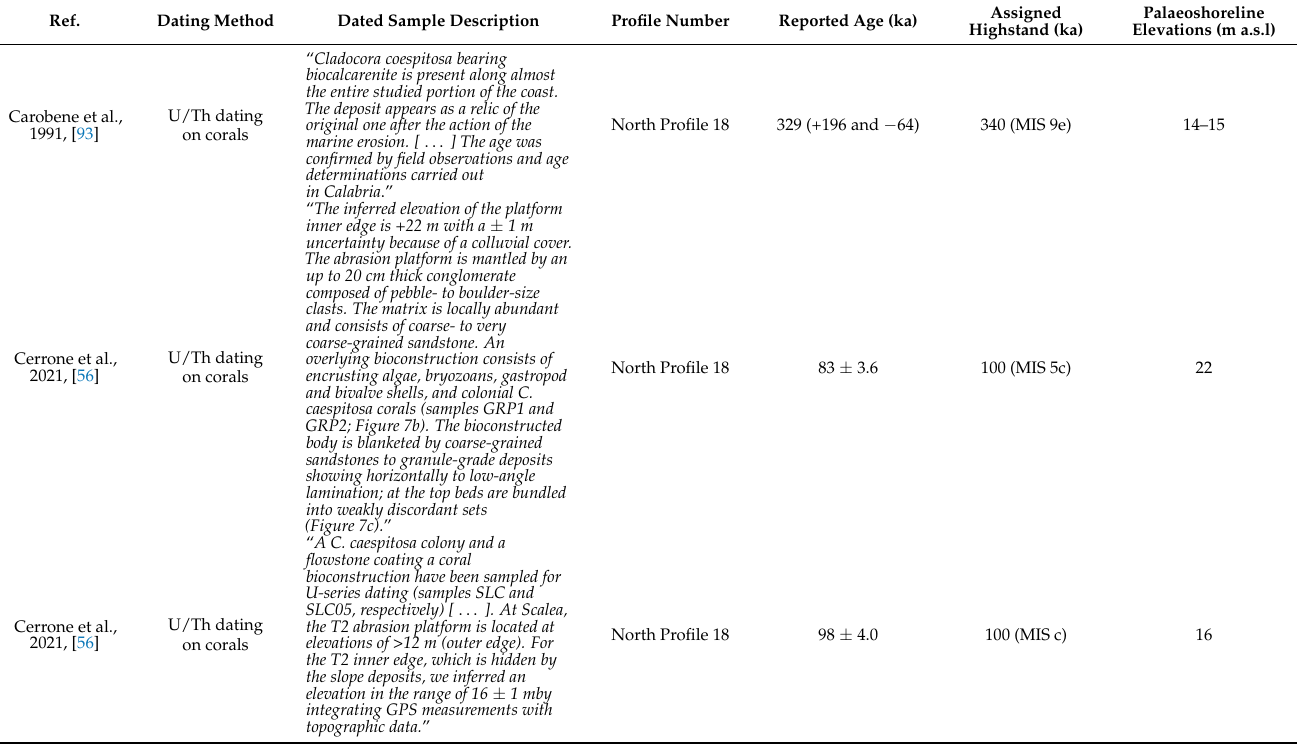
Table 1. Age controls associated with the studied sequence of marine terraces taken from the literature. Ref.